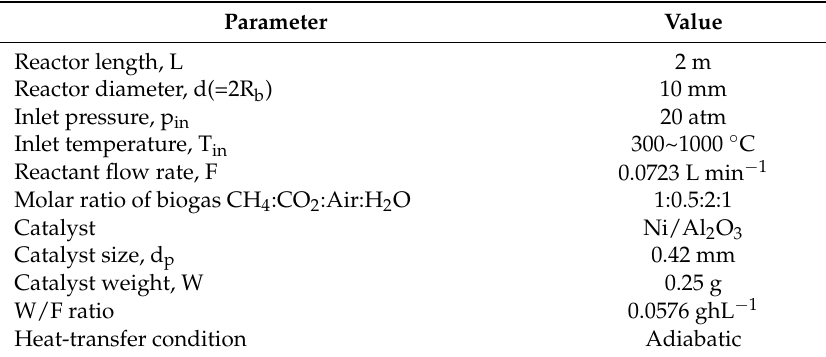
Table 1. Reactor geometry and base operation conditions